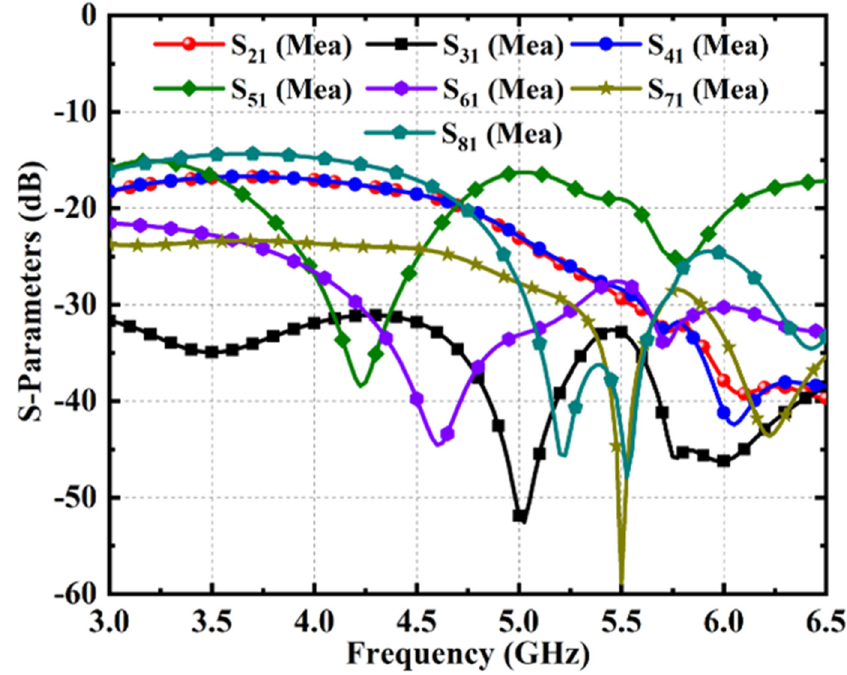
Figure 11. Isolation response (measured).